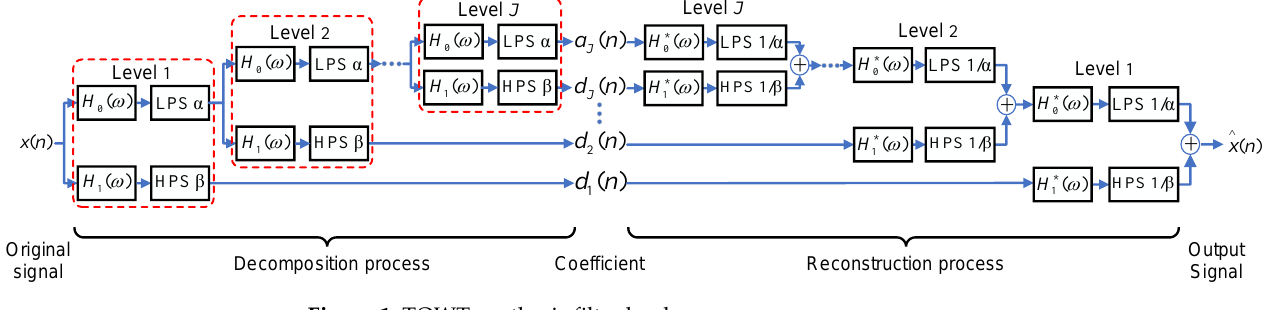
Figure 1. TQWT synthesis filter bank.